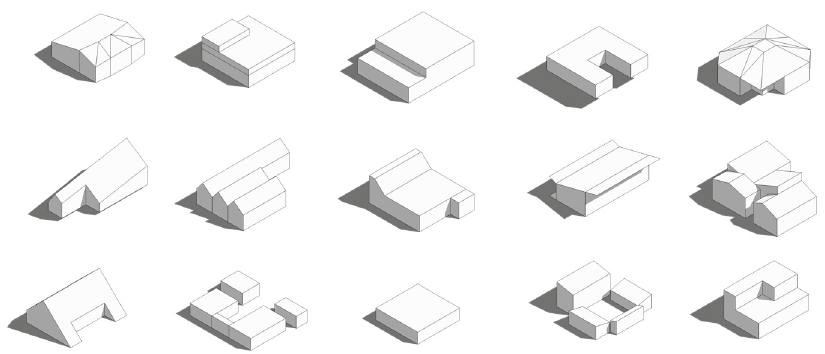
Figure 5. Building plane shape.